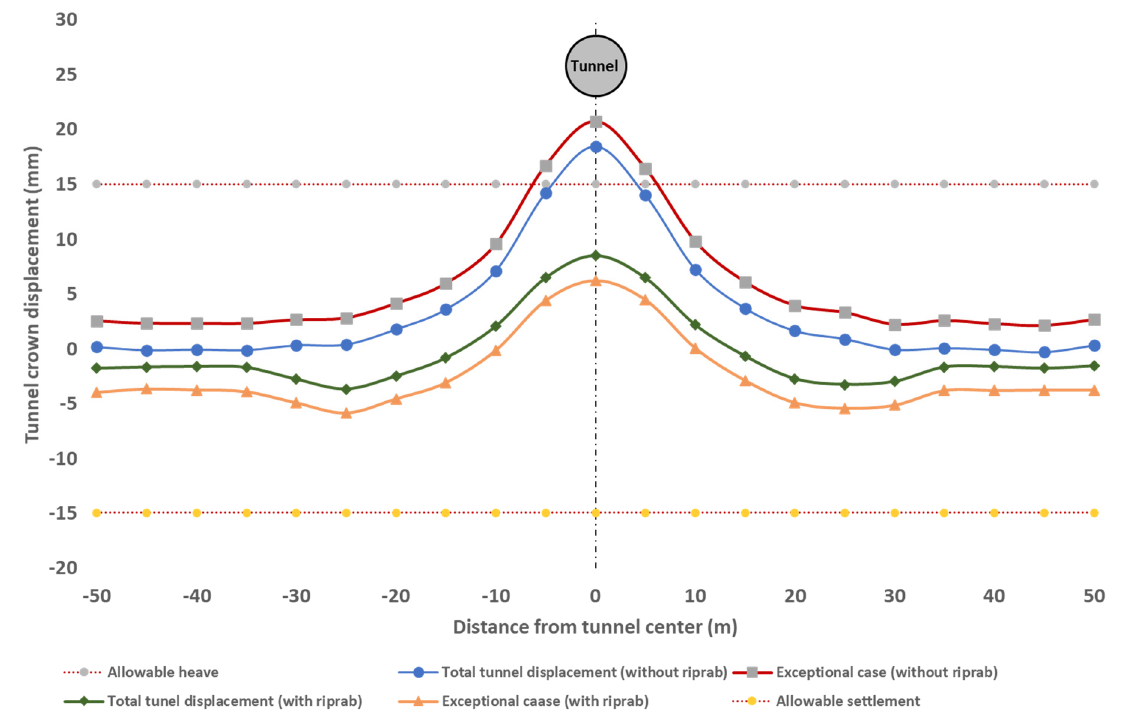
Figure 21. Horizontal surface settlement displacement and transverse trough during service